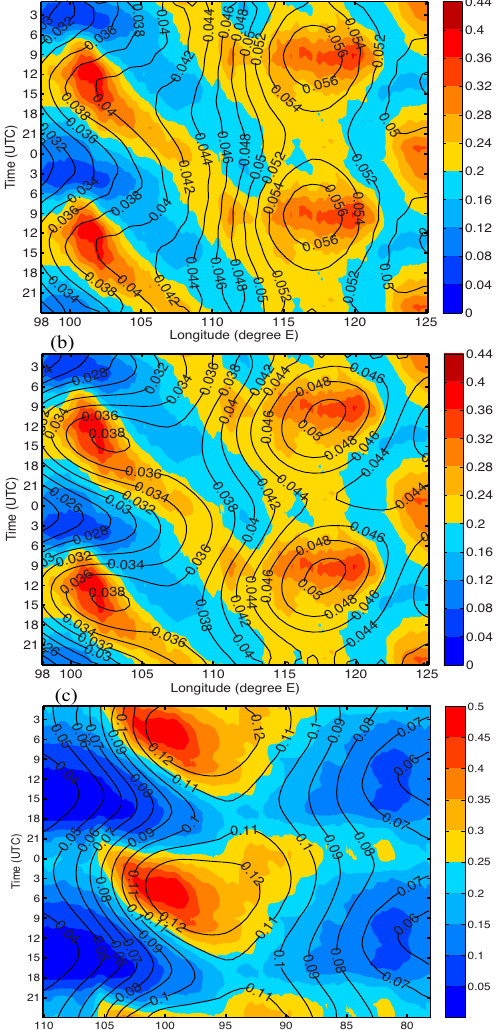
Figure 18. Time-longitude diagram of the diurnal variation in the hourly precipitation 2 Figure 18. Time–longitude diagram of the diurnal variation in the hourly precipitation (shadings, units: mmh − 1 ) and the filtered pre- (shadings, units: mmh -1 ) and the filtered precipitation perturbation variances (contours) for (a) 3 cipitation perturbation variances (contours) for (a) SR3 and (b) SR4 SR3 and (b) SR4 over East Asia, contours interval is 0.02 and (c) for with SR3 for North 4 over East Asia, contours interval is 0.02 and (c) for with SR3 for North America, contours interval is America, contours interval is 0.01. 5